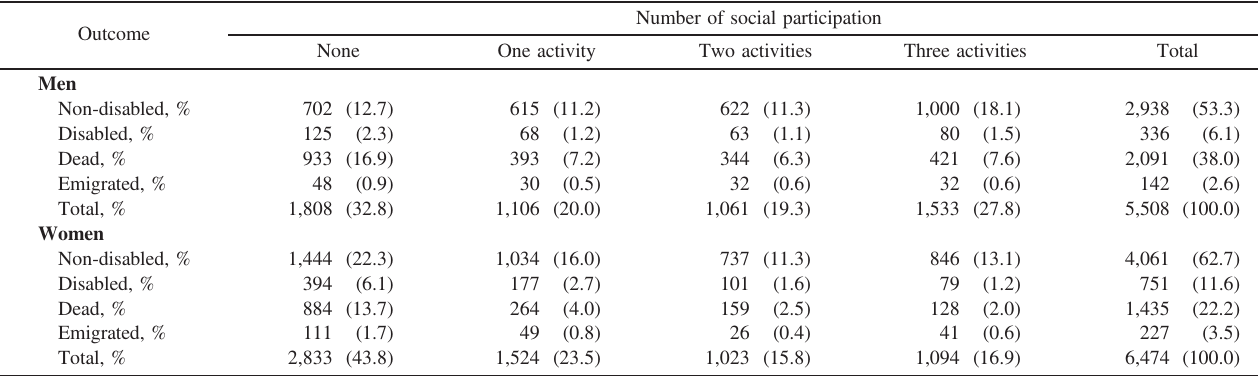
Table 2. The distribution of participants in the outcome in 2017 by the number of social participation ( n = 11,982) Number of social participation Outcome None One activity Two